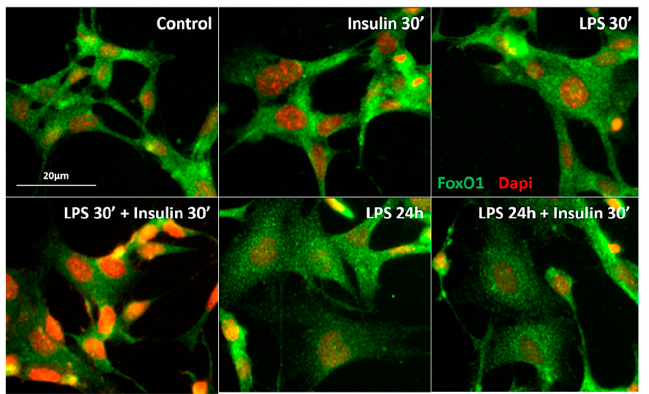
Figure 5. Prolonged LPS treatment impairs the ability of insulin to translocate Forkhead box protein O1 (FoxO1) from the nucleus to the cytoplasm. Representative photomicrograph of the qualitative FoxO1 immunostaning in the mouse GT1-7 cell line after short (30 ′ ) LPS (1 μ g/mL), insulin (100 mM/mL), LPS (30 ′ ) + insulin, prolonged (24 h) LPS, or LPS (24 h) + insulin treatment. FoxO1 expression is in green and DAPI nuclear expression is in red. Scale bar: 20 μ m.